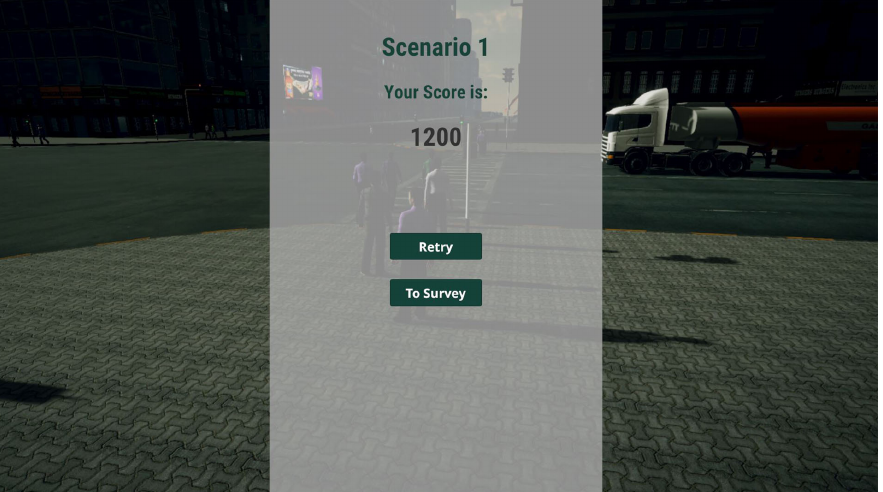
Figure 2. The Score/Game Over Scene shows the participant’s score based on their successful intersection